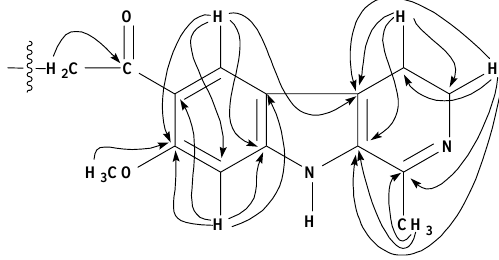
Figure 1. Significant HMBC ( 1 H (cid:198) 13 C) interactions of 10-acyl analogues of 1 .